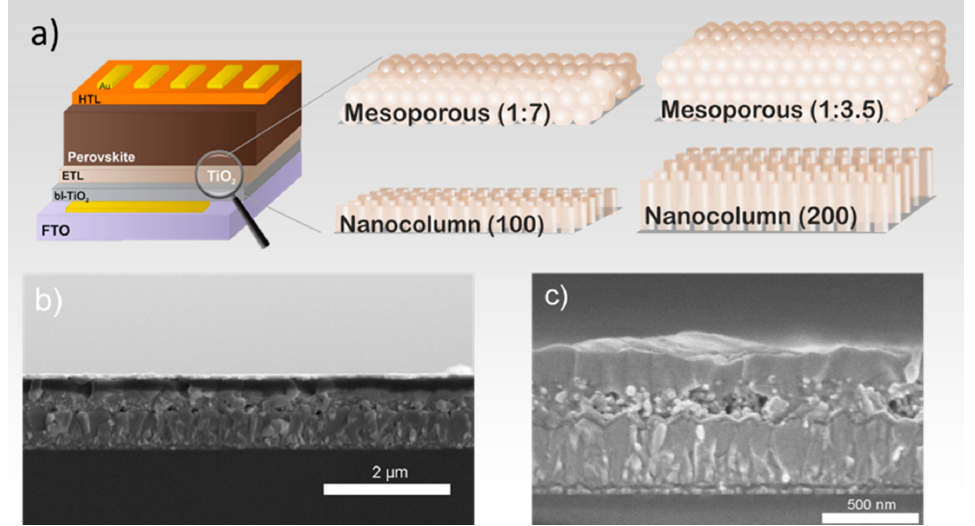
Figure 1. ( a ) Cross-sectional device scheme and electron selective layer (ESL) used, ( b ) scanning electron microscopy (SEM) image of PSC with 1:7 TiO 2 mesoporous structure and ( c ) SEM image of PSC with 1:3.5 TiO 2 mesoporous structure.